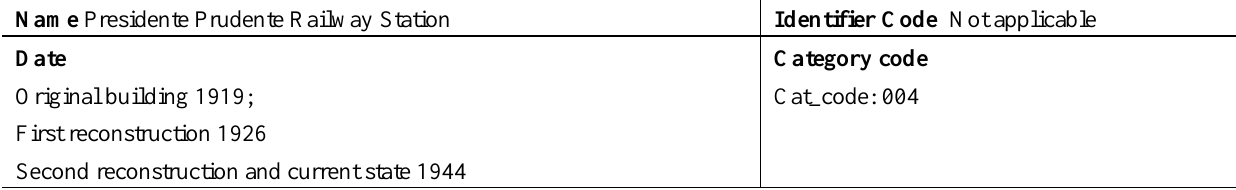
Table 4. Descriptive information records of Presidente Prudente Railway